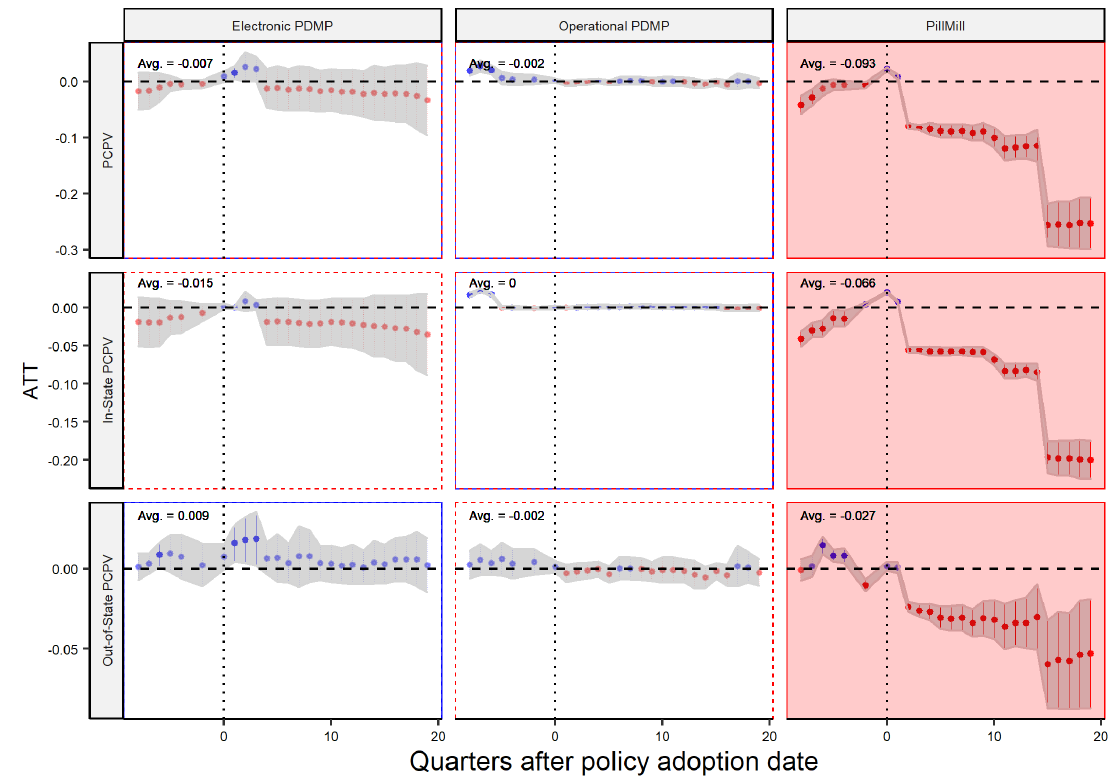
Figure 8. Policy Effect—Player: